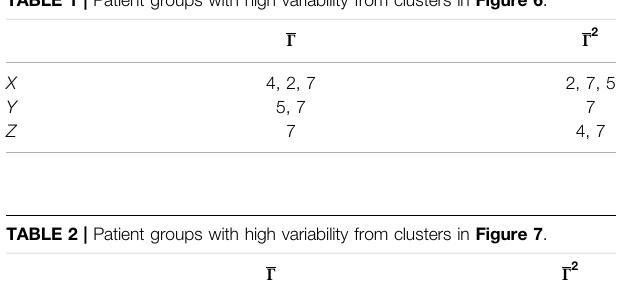
TABLE 1 | Patient groups with high variability from clusters in Figure 6 .